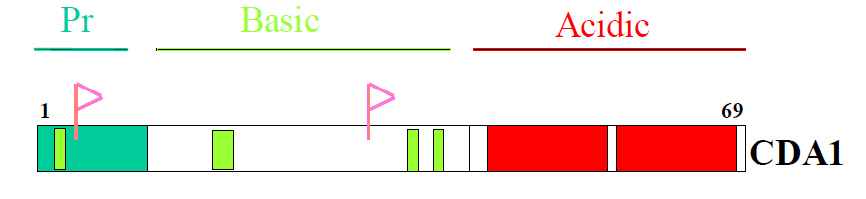
Figure 1. Domain structure of CDA1 showing proline-rich domain (Pr), basic and acidic domains with four nuclear localization signals (bars) and two consensus phosphorylation sites